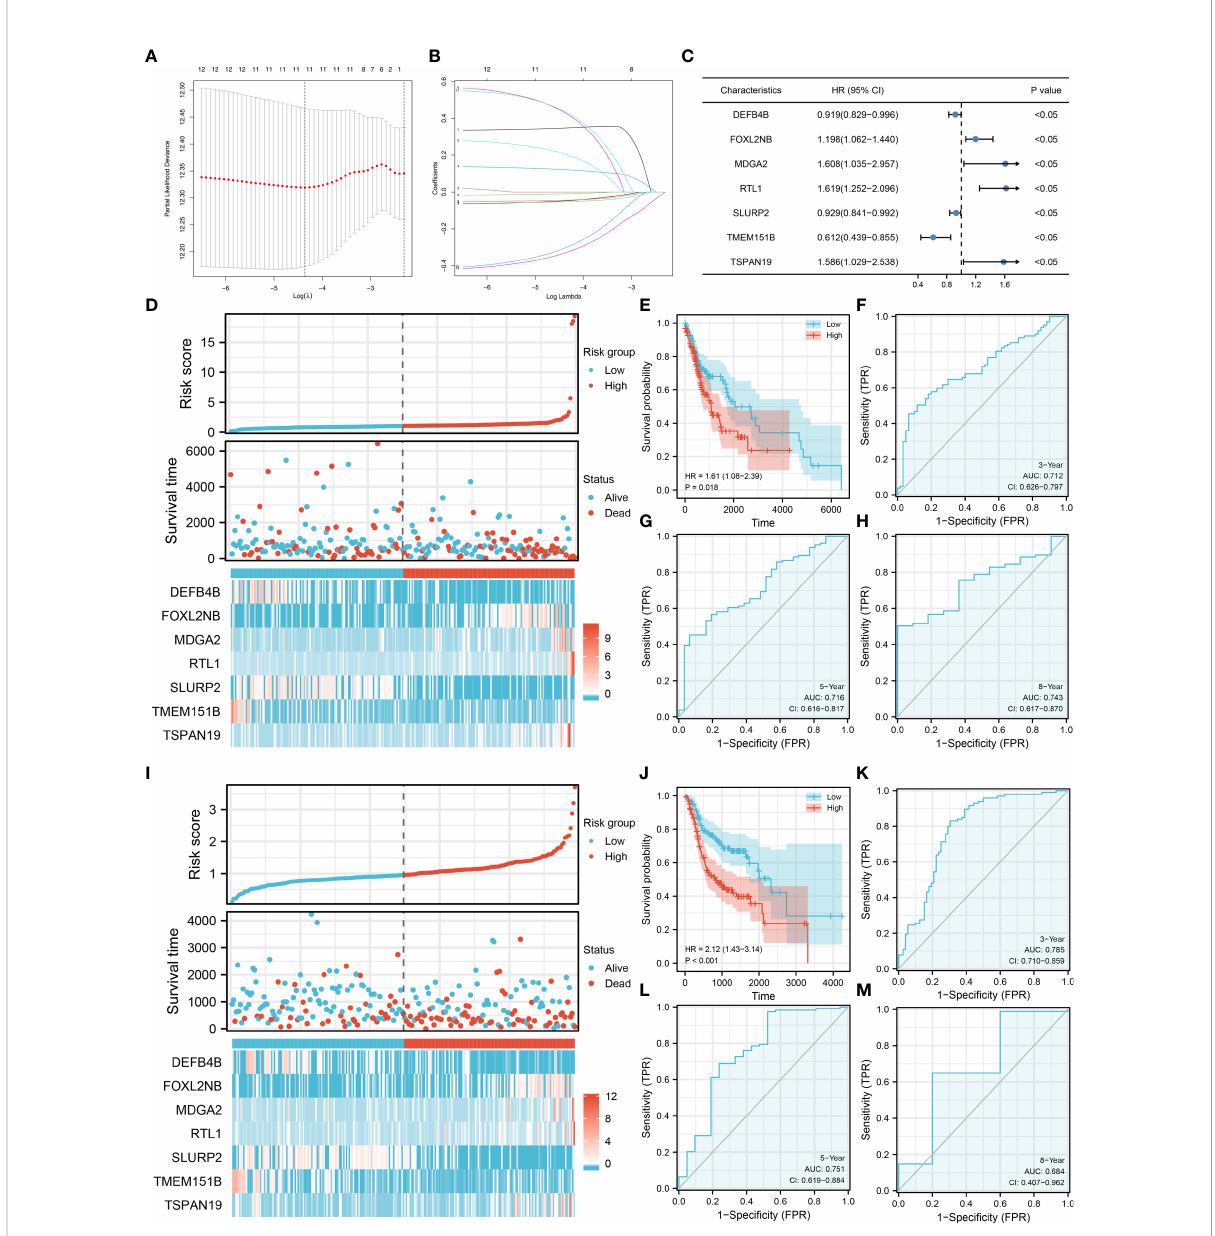
FIGURE 3 Model construction and validation. (A – B) LASSO regression analysis was performed for dimensionality reduction; (C) Multivariate Cox analysis was performed for prognosis model construction, including DEFB4B, FOXL2NB, MDGA2, RTL1, SLURP2, TMEM151B and TSPAN19; (D) The overview of prognosis model in training cohort; (E – H) Kaplan-Meier survival and ROC curves for prognosis model evaluation in the training cohort; (I) The overview of prognosis model in validation cohort; (J – M) Kaplan-Meier survival and ROC curves for prognosis model evaluation in the validation